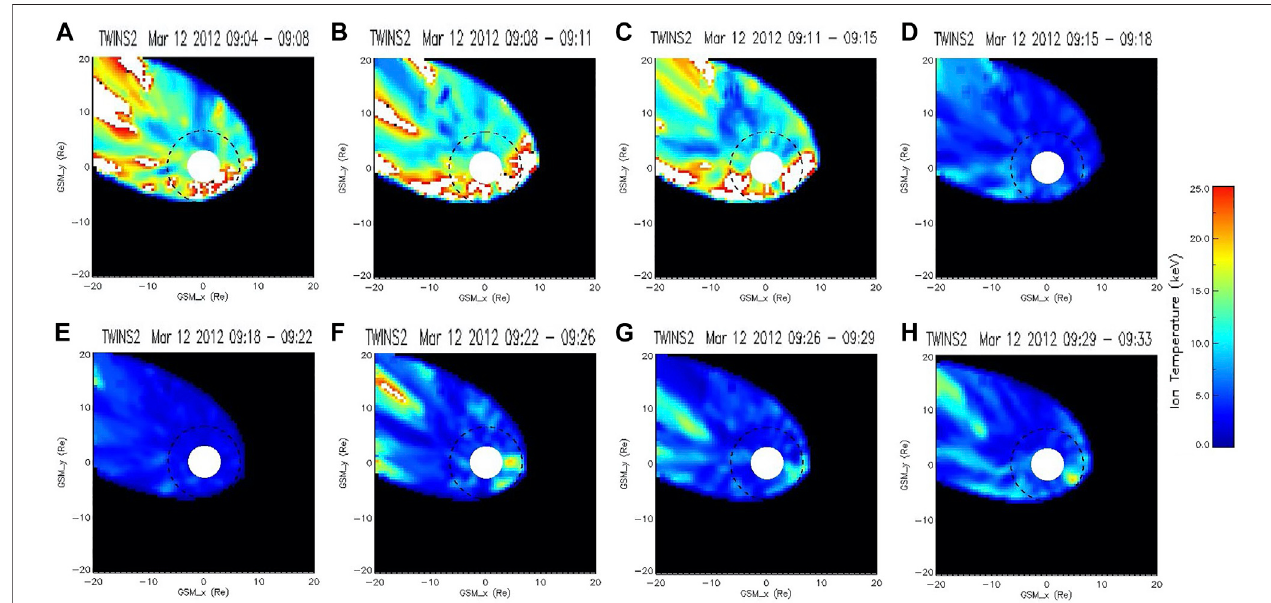
FIGURE2| IontemperaturemapsoftheGSMxy-planecalculatedfromTWINSmeasurementsfor9:04 – 9:33UT.TheSunistotheright,thewhitedischasaradius of 3 Re and is centered at Earth and the dashed line indicates geosynchronous orbit.